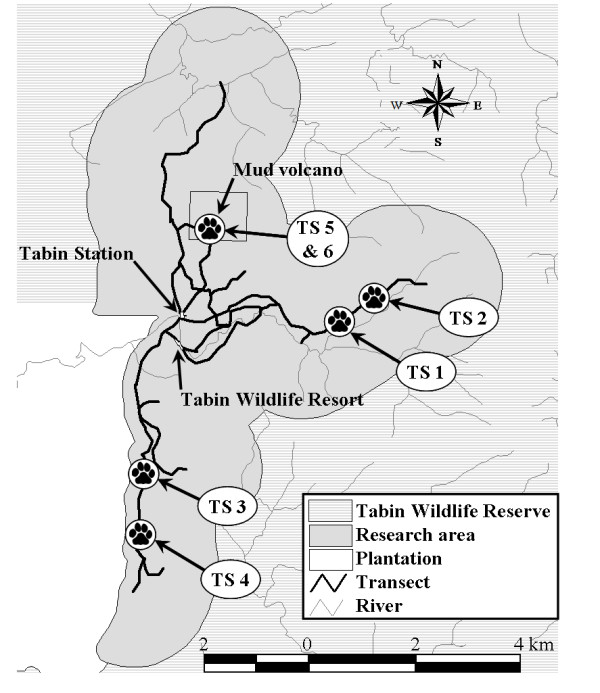
Location of the track sets (TS) of clouded leopards within the study site.